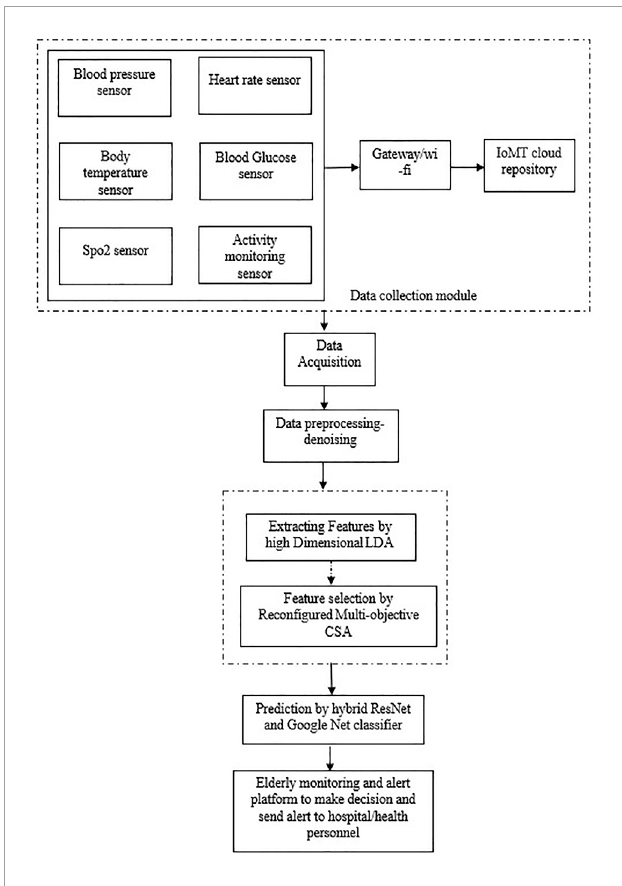
FIGURE 1 Flow of proposed